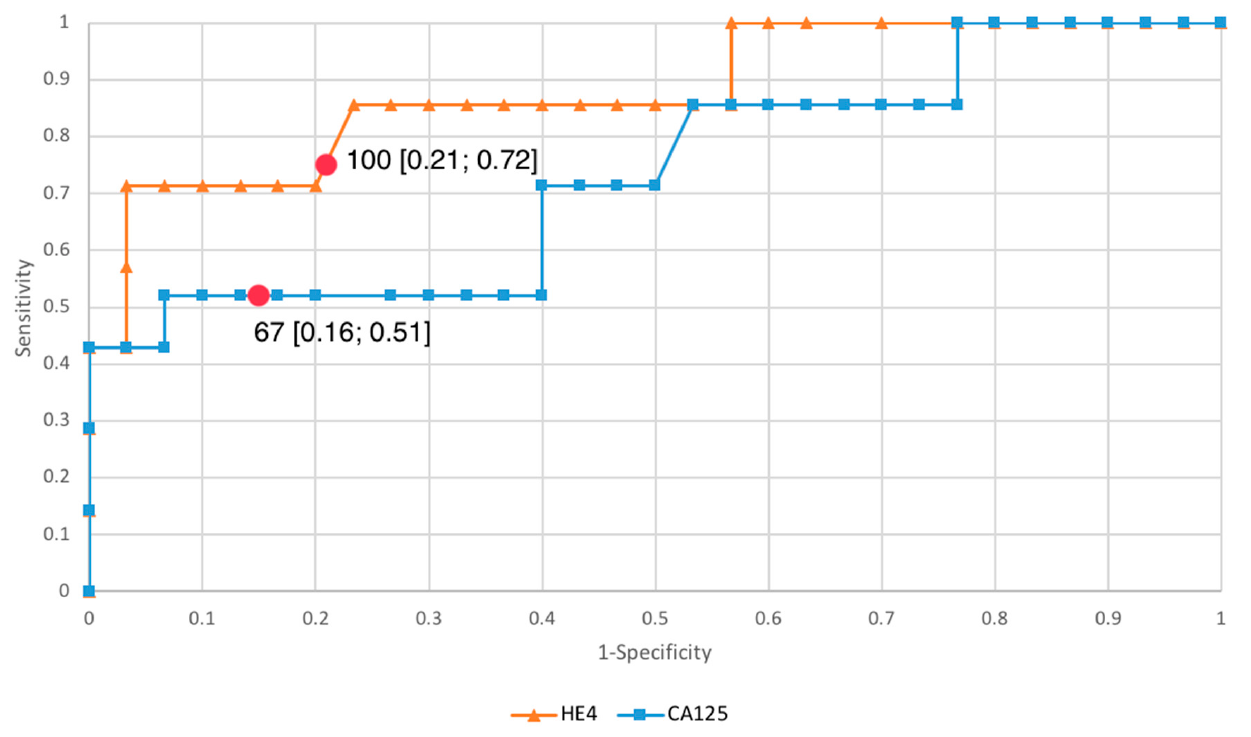
Figure 1. ROC curves for HE4 and CA125.